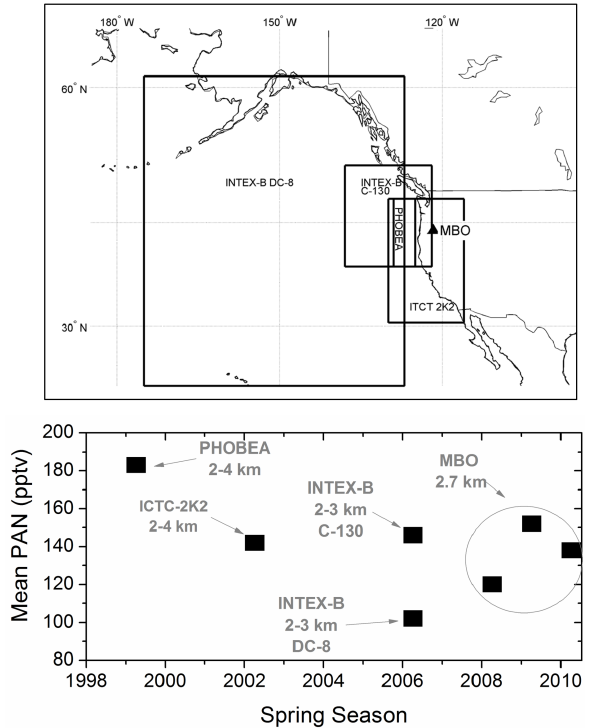
Figure 2: Top: The location of MBO and previous airborne observations in the Eastern Pacific 951 Fig. 2. Top: the location of MBO and previous airborne observa- Region (black boxes) (Roberts et al., 2004; Zhang et al., 2008; Kotchenruther et al., 2001a). 952 tions in the Eastern Pacific Region (black boxes) (Roberts et al., Bottom: Mean PAN mixing ratios during spring from MBO and previous airborne campaigns. 953 2004; Zhang et al., 2008; Kotchenruther et al., 2001a). Bottom: mean PAN mixing ratios during spring from MBO and previous air- The latitude and longitude ranges shown in the map for the INTEX-B observations are associated 954 borne campaigns. The latitude and longitude ranges shown in the with samples collected between 2 and 3 km. The mean PAN mixing ratios observed at MBO 955 map for the INTEX-B observations are associated with samples col- during spring 2006 was 340 pptv (Wolfe et al., 2007). 956 lected between 2 and 3km. The mean PAN mixing ratio observed at MBO during spring 2006 was 340pptv (Wolfe et al.,